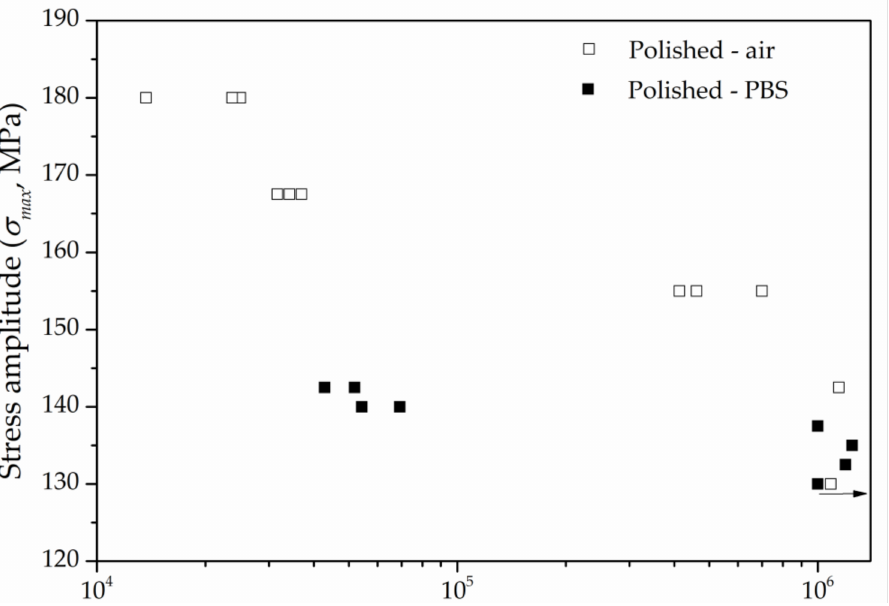
Figure 5. S- N curves for the polished AZ31B alloy specimens in air and in PBS solution at room temperature. The S- N curves for the anodized specimens exposed to air and PBS solution